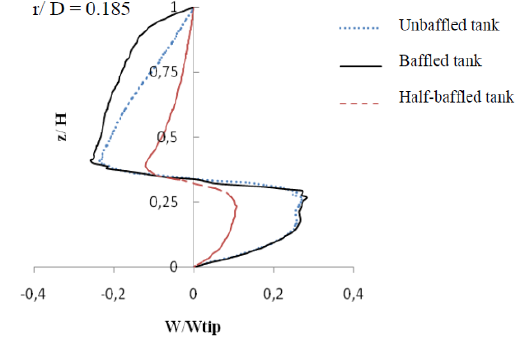
Figure 6. Axial profile of the tangential velocity.